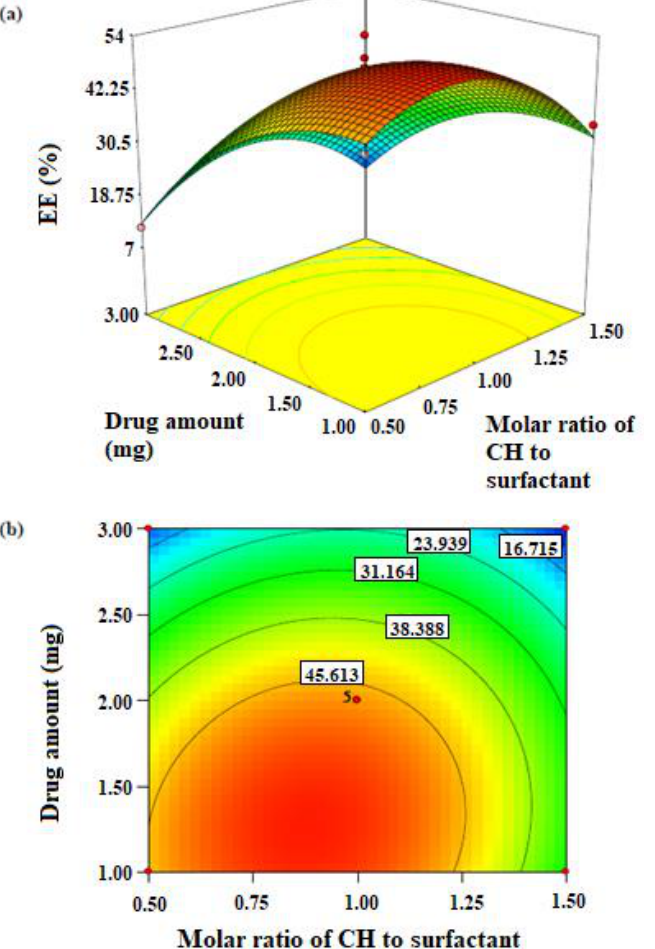
Figure 1. ( a ) Three-dimensional surface plot for EE of EGCG-niosome as a function of the formulation variables. ( b ) Contour plot for EE of EGCG-niosome as a function of the formulation variables.